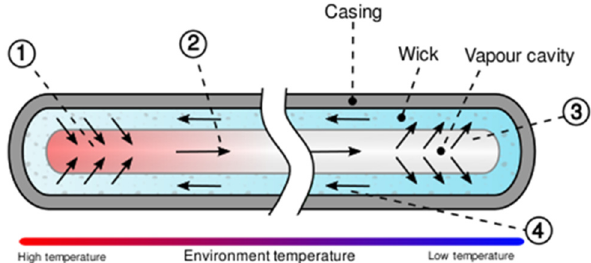
Figure 1. Operating principle of HP: (1) the heat from the heat source is absorbed by the liquid working fluid located inside the wick in the evaporation section, and the working fluid evaporates; (2) saturated vapour travels to the colder condenser section driven by the vapour pressure difference; (3) in the condenser, vapour releases the heat to a heat sink where it condenses back to a liquid state and is absorbed by the wick; (4) condensed liquid returns to the evaporator section through the wick structure by capillary forces [2].